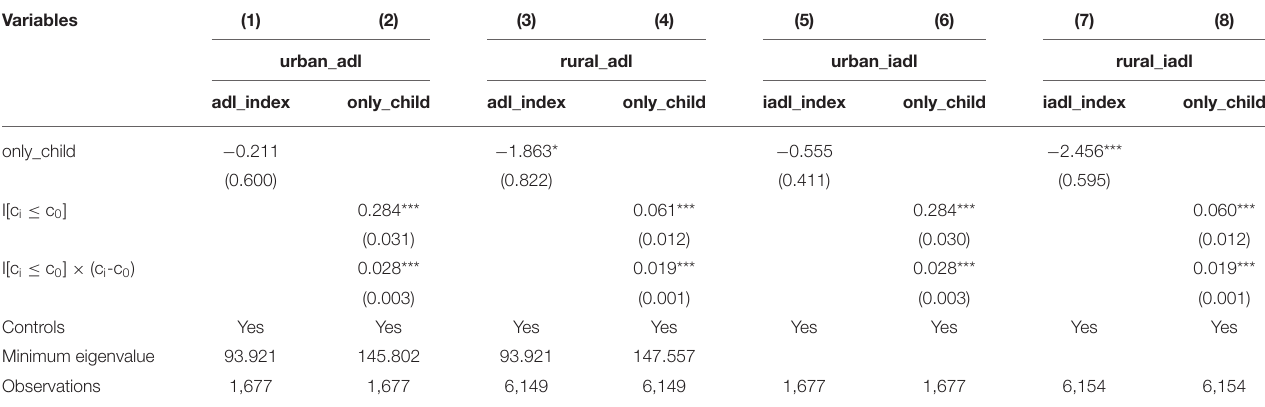
TABLE 6 | The robustness check (1).